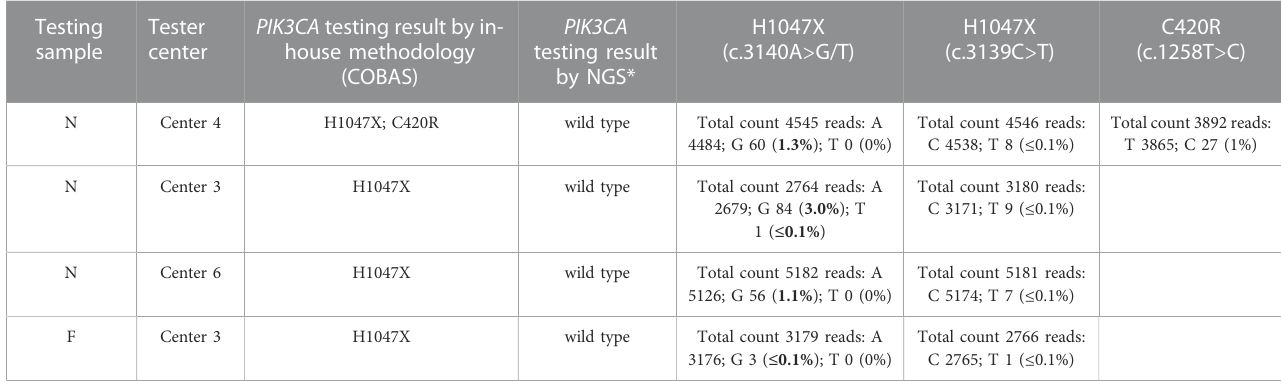
TABLE 5 PIK3CA testing results of NGS reanalysis by IPATIMUP reference center. Testing